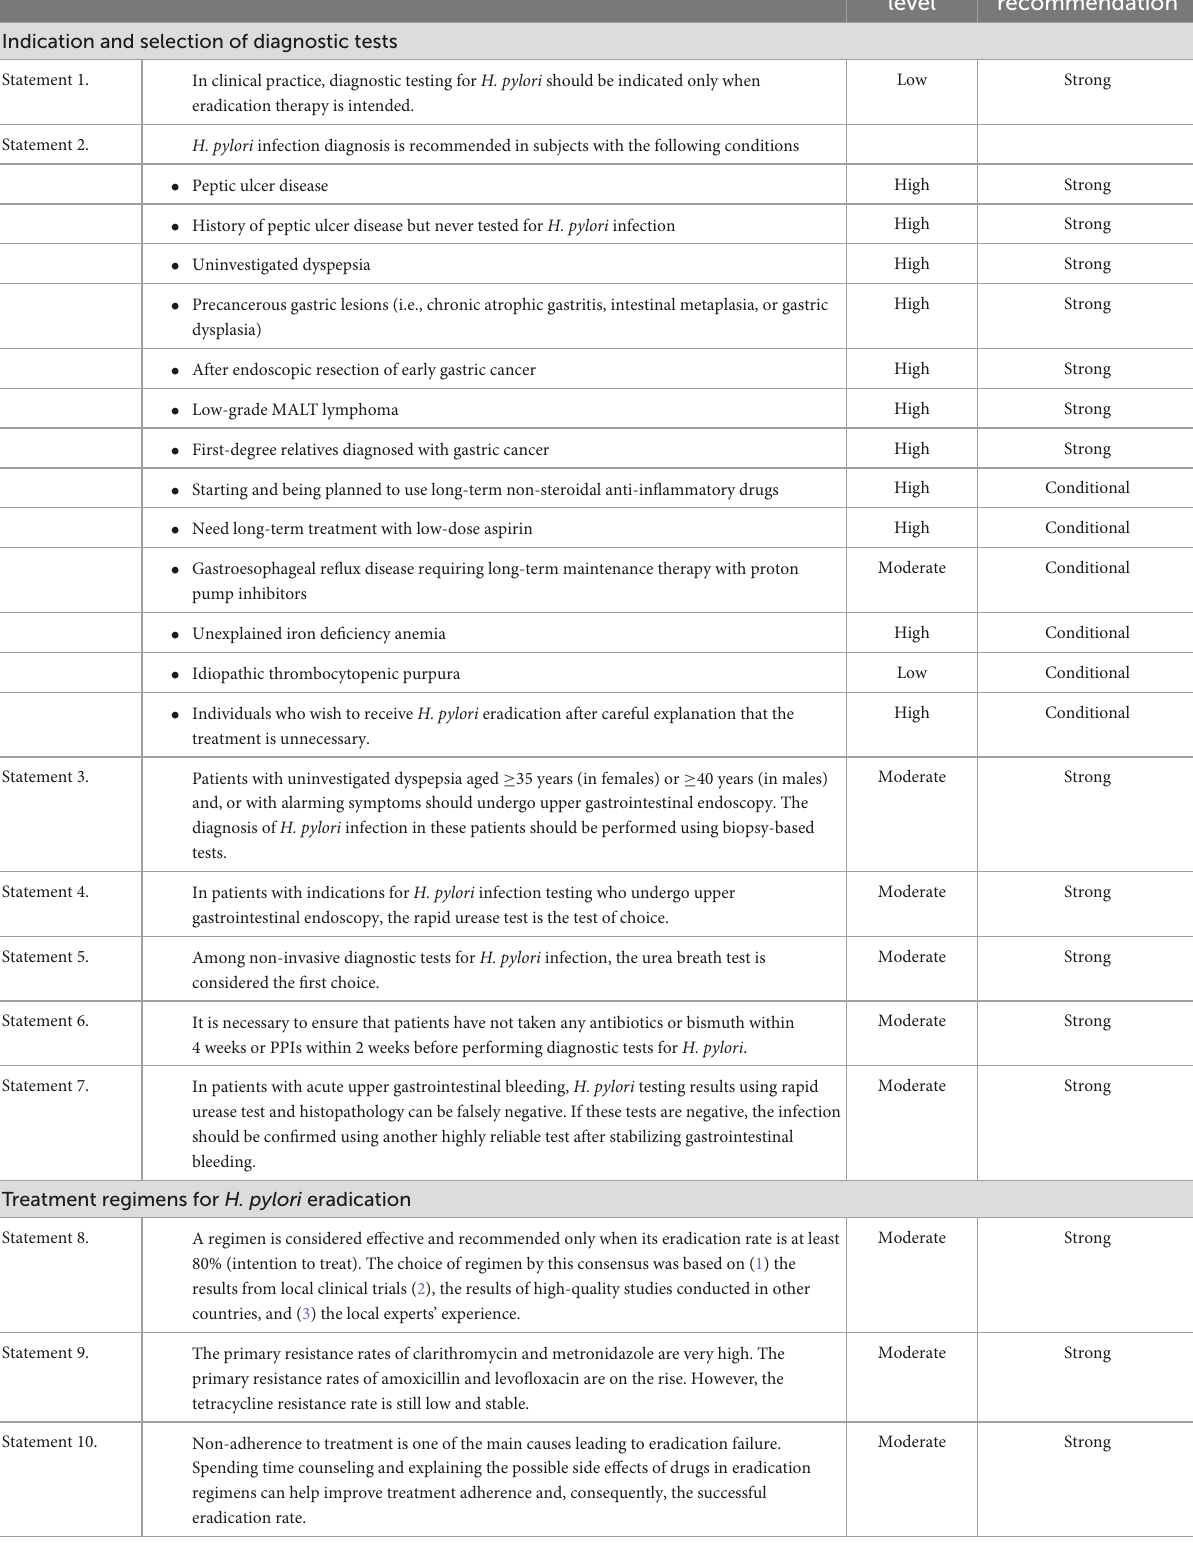
TABLE 1 Summary of recommendations. Recommendations Indication and selection of diagnostic